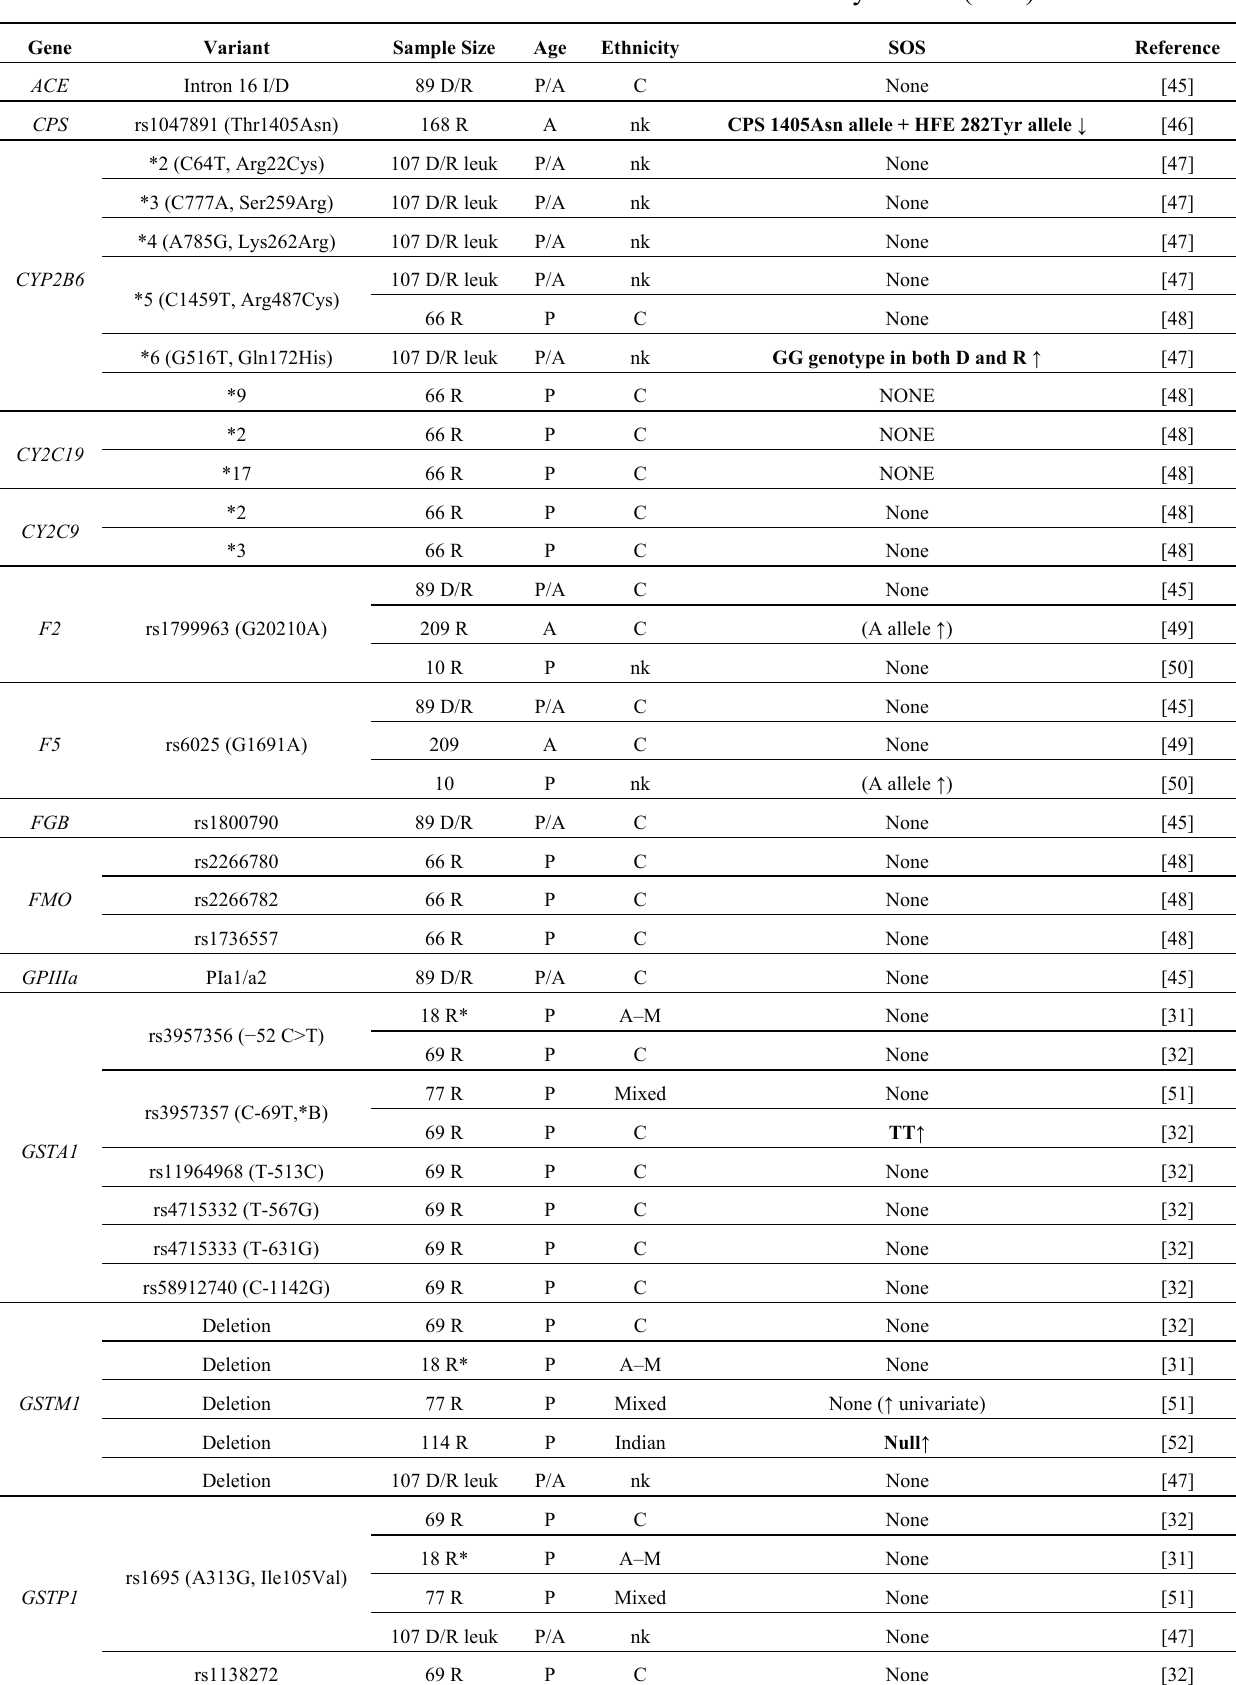
Table 2. Genetic association studies with sinusoidal obstructive syndrome (SOS) in HSCT. Gene Variant Sample Size Age Ethnicity SOS